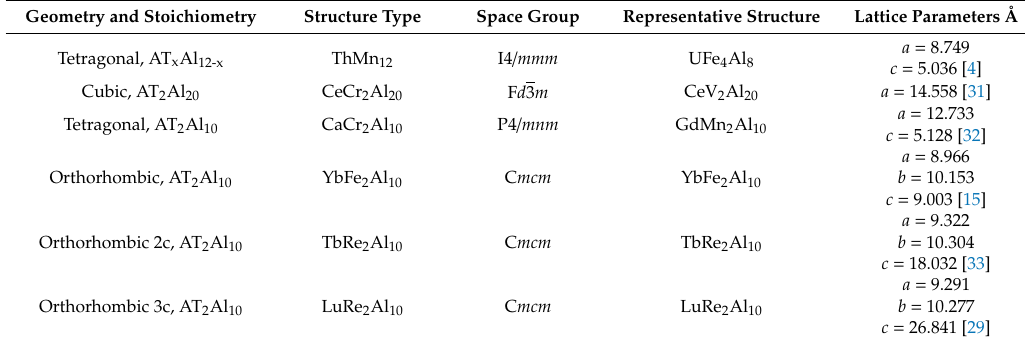
Figure 1. Unit cell representation of the discussed structures: ( a ) tetragonal, AT x Al 12-x (ThMn 12 -type); ( b ) cubic, AT 2 Al 20 (CeCr 2 Al 20 -type); ( c ) tetragonal, AT 2 Al 10 (CaCr 2 Al 10 -type); ( d ) orthorhombic, AT 2 Al 10 (YbFe 2 Al 10 –type); ( e ) orthorhombic 2 c , AT 2 Al 10 (TbRe 2 Al 10 –type); ( f ) orthorhombic 3 c , AT 2 Al 10 (LuRe 2 Al 10 –type). The unit cell were visualized using Diamond commercial software. Table 1. Crystallographic parameters of the Al-richest A-T-Al structures.